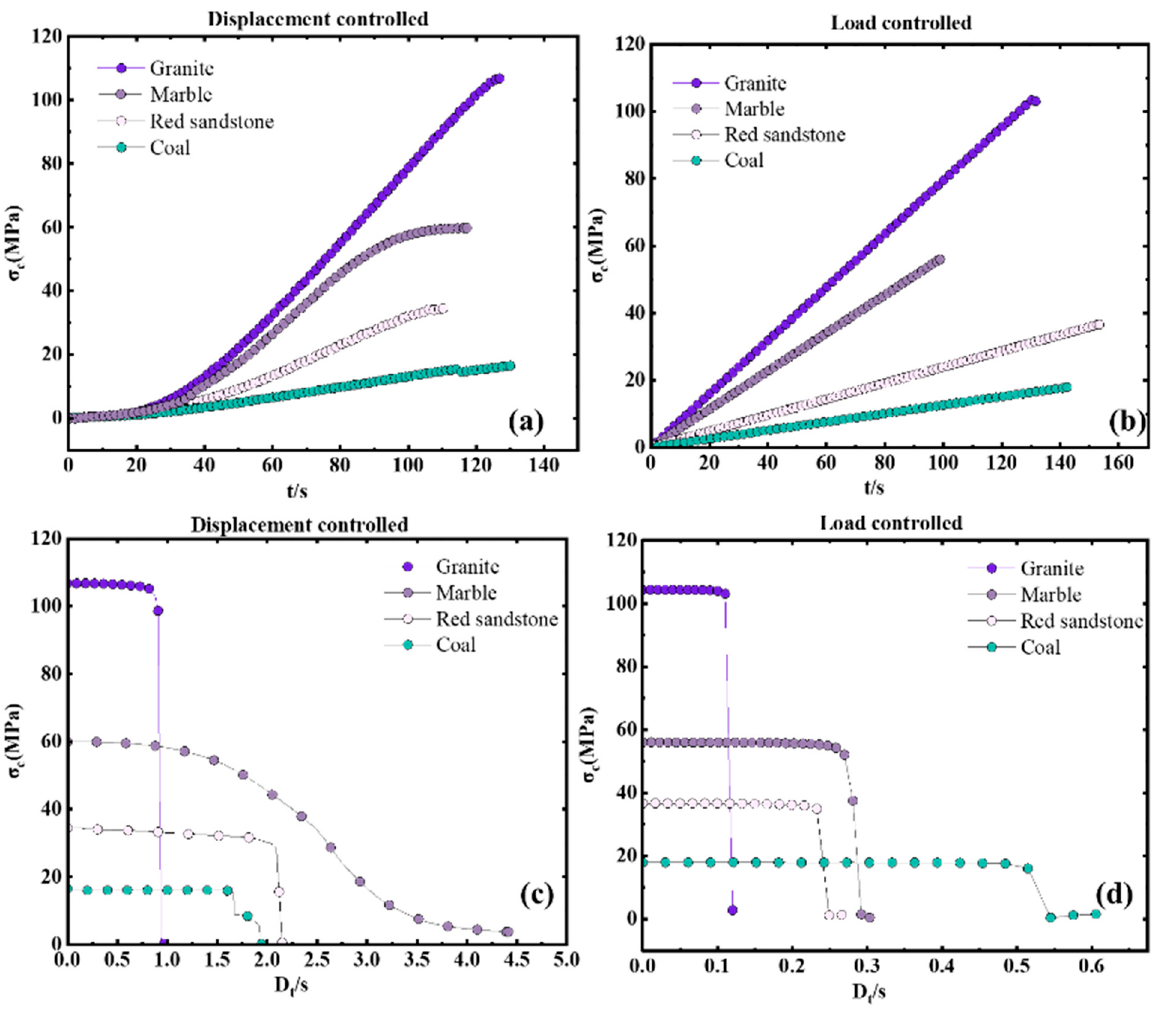
Figure 9. Stress-time curves of rocks in uniaxial compression tests ( a , c ) with a loading rate of 0.5 mm/min; ( b , d ) with a loading rate of 93 kN/min.